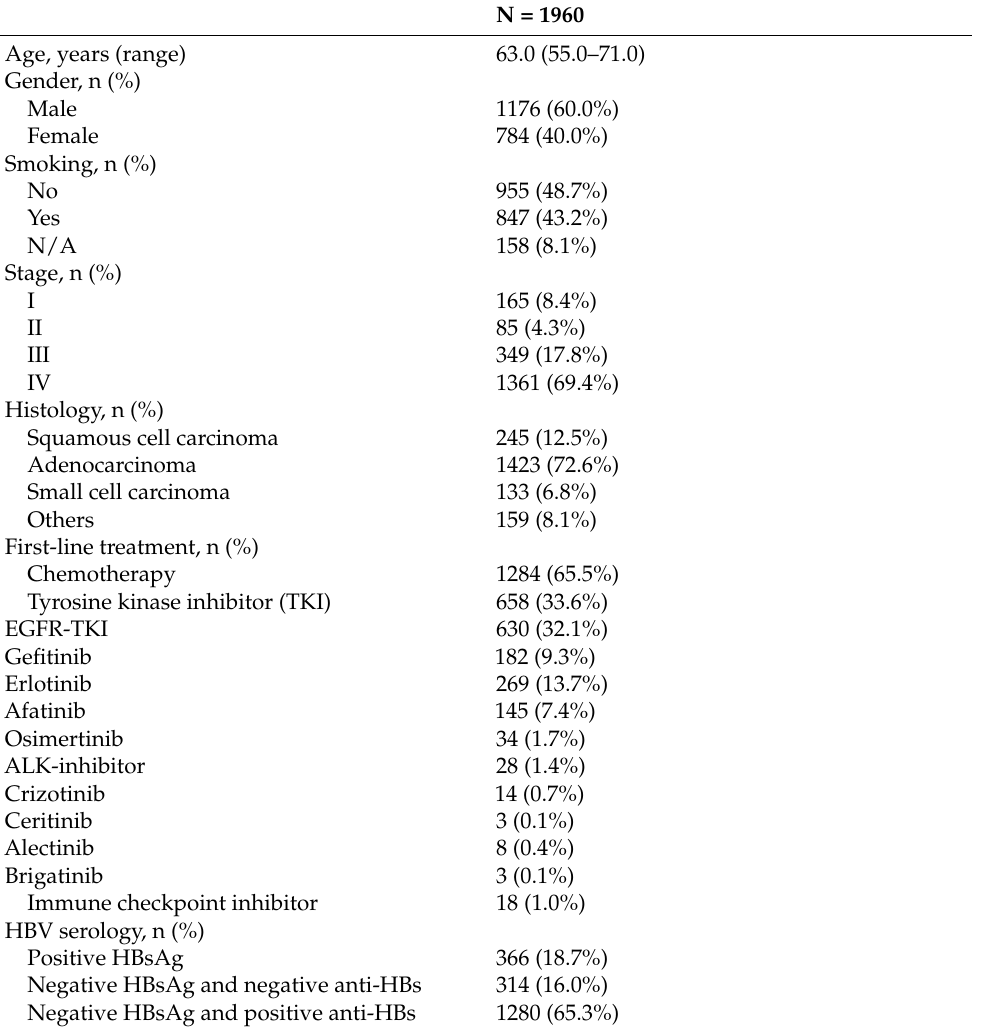
Table 1. Clinical characteristics of the included patients. N/A, not available; TKI, tyrosine kinase